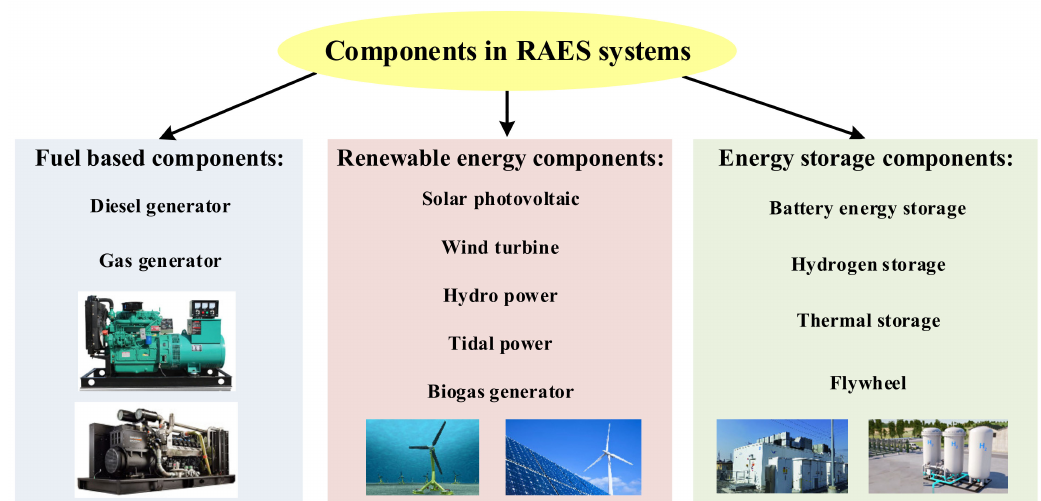
Figure 5. System components in remote area electricity supply systems.